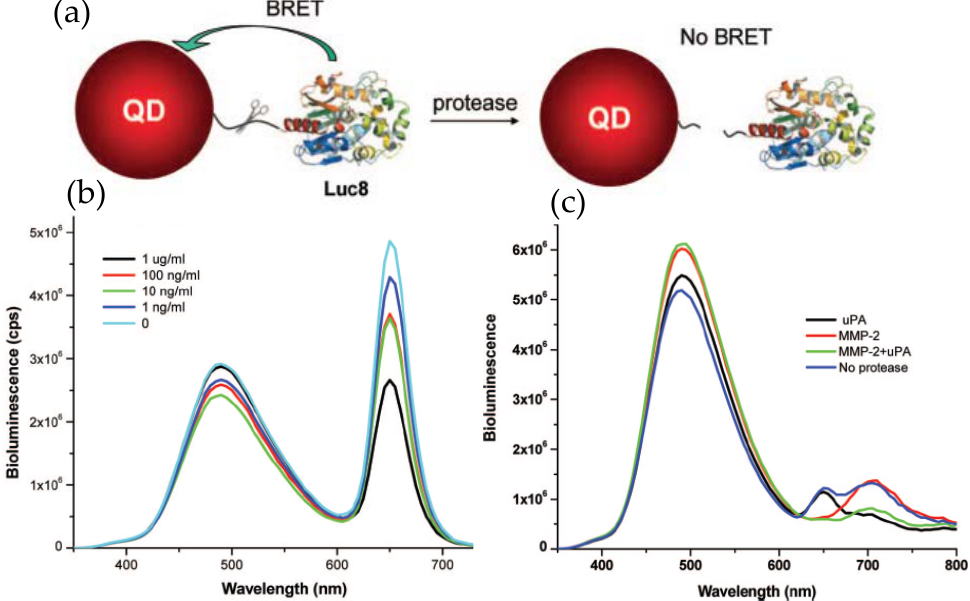
Figure 4. Application of QD–Luc conjugates as a protease sensor. ( a ) Schematic displaying the detection principle where the target protease cleaves its substrate peptide allowing the QD and Luc to diffuse away and concurrently reducing the BRET-sensitized QD emission. ( b ) Representative emission spectra displaying reduced QD emission with increased MMP-2 concentration. ( c ) Simultaneous detection of two different proteases, MMP-2 and urokinase (uPA), with two different probes, QD655-Luc and QD705-Luc, respectively. In the presence of specific protease, a drop in QD intensity at its respective peak was observed. Reprinted with permission from [48]. Copyright 2008 American Chemical Society.